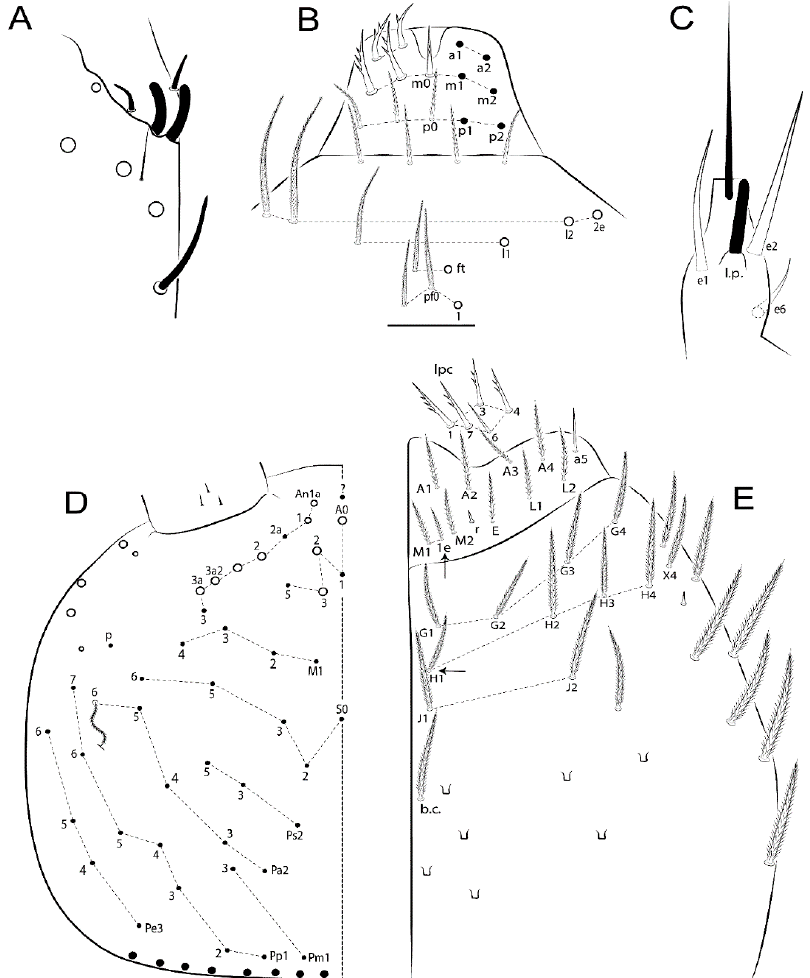
Figure 34. Pseudosinella unimacrochaetosa sp. nov.: head. ( A ) Ant III apical organ (lateral view); ( B ) chaetotaxy of clypeus, prelabrum, and labrum; ( C ) labial papilla E (right side); ( D ) head dorsal chaetotaxy (left side); ( E ) labial proximal chaetae, basomedian and basolateral labial fields, and complete postlabial chaetotaxy (right side), arrows indicate chaetae present or absent.